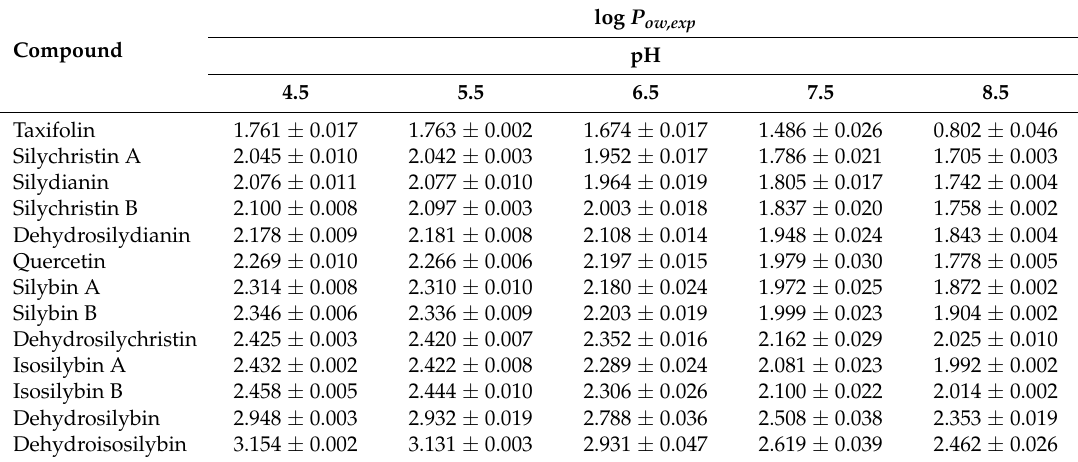
Table 1. Hydrophobicity (log P ow,exp ) of studied compounds in phosphate